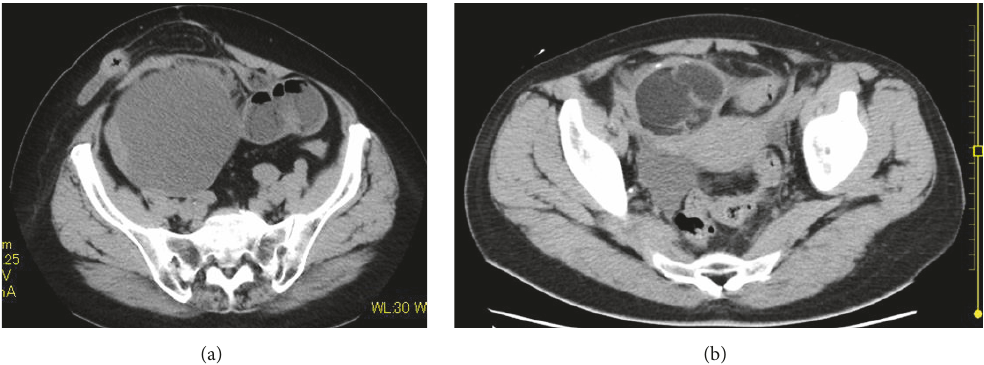
Figure 1: (a) Abdominal plain computed tomography (current). A huge mass measuring 21cm in longest diameter can be seen in the right cranial portion of the uterine body. The mass is partially solid, suggesting malignancy. (b) Abdominal plain computed tomography (image obtained 10 years prior to the current admission). A mature cystic teratoma measuring 6 cm in diameter is observed on the right side. There are no findings suggestive of malignancy, such as a mural nodule or a solid component.